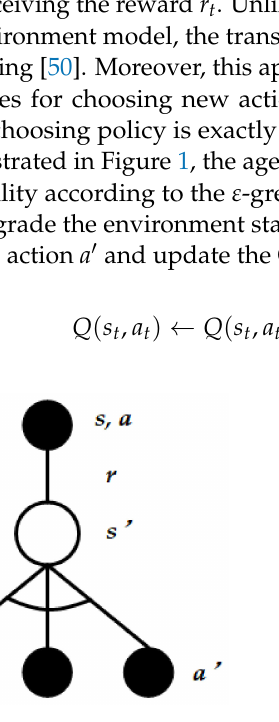
Figure 1. Simple model of Q